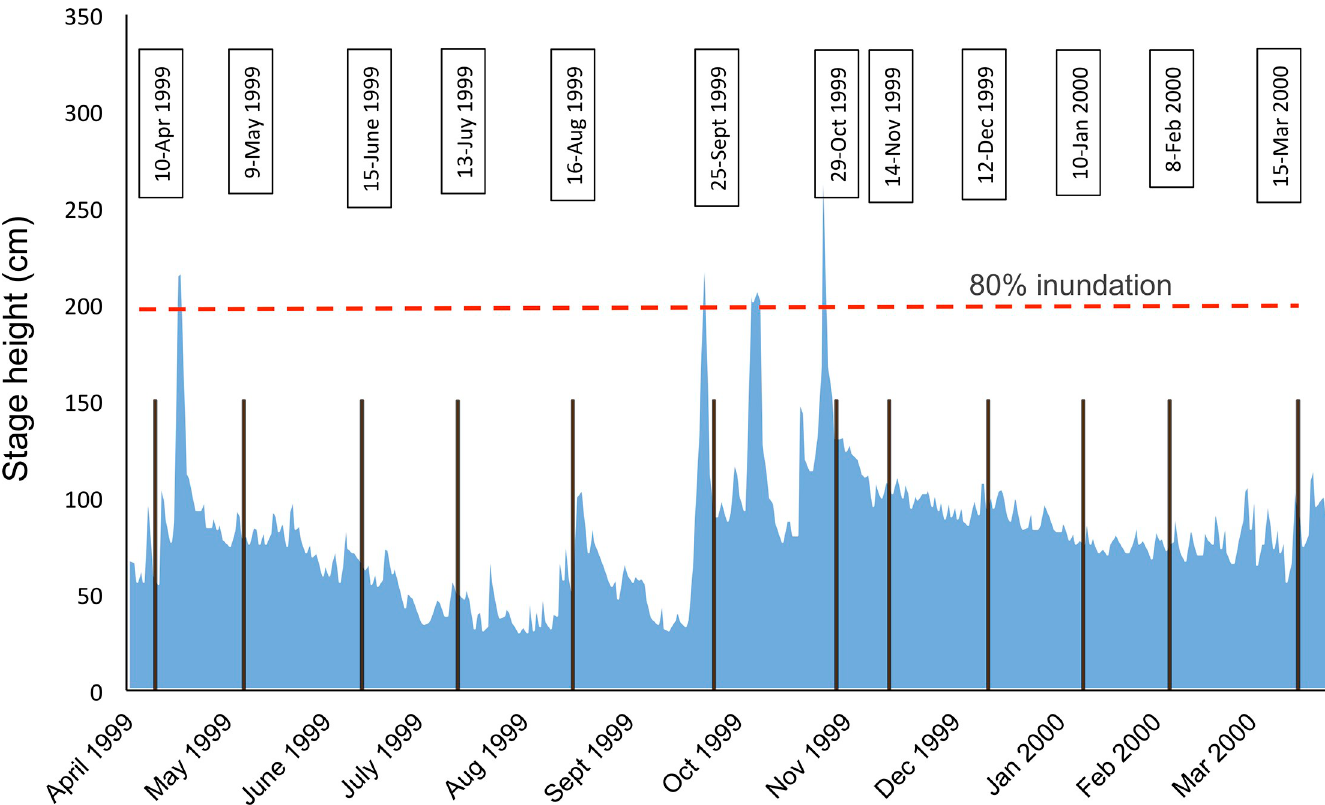
Fig 2. Hydrograph of the study period. Plot of the hydrograph showing stage height (cm) from April 1999 to March 2000, measured at the S. Pietro gauging station (3 km downstream of the study reach). Vertical bars indicate the time of invertebrate sampling with exact date listed in text boxes above. The red horizontal dashed line indicates the level where 80% of the study floodplain was inundated. Four main flooding events occurred during the sampling period.